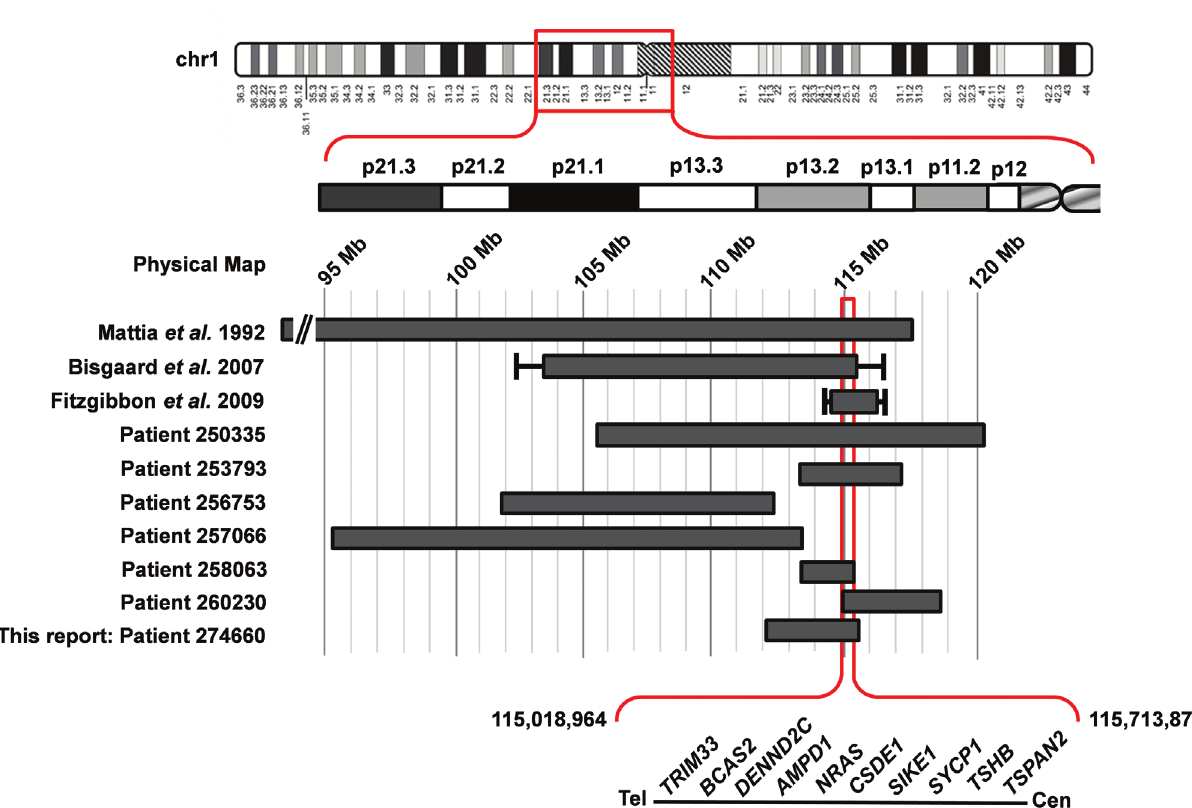
Figure 3 - Schematic representation of the deleted segments in our patient and those previously reported with isolated 1p13.2 microdeletions. Except for the patient described by Mattia et al. (1992), who has a microdeletion from 1p13 to 1p22.3, all other patients have their breakpoints defined by molecular